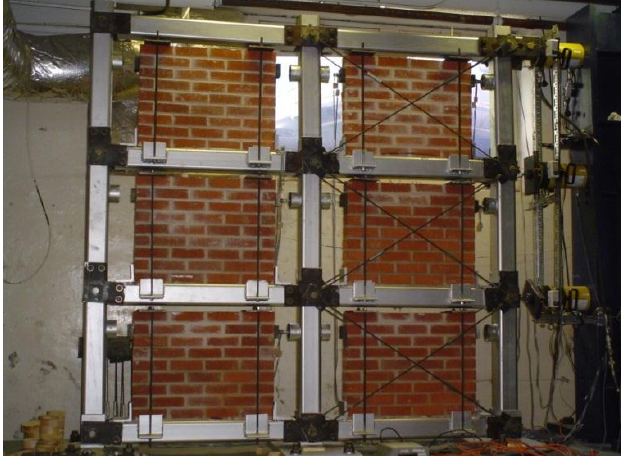
Figure 2. Concrete test platform and steel reaction